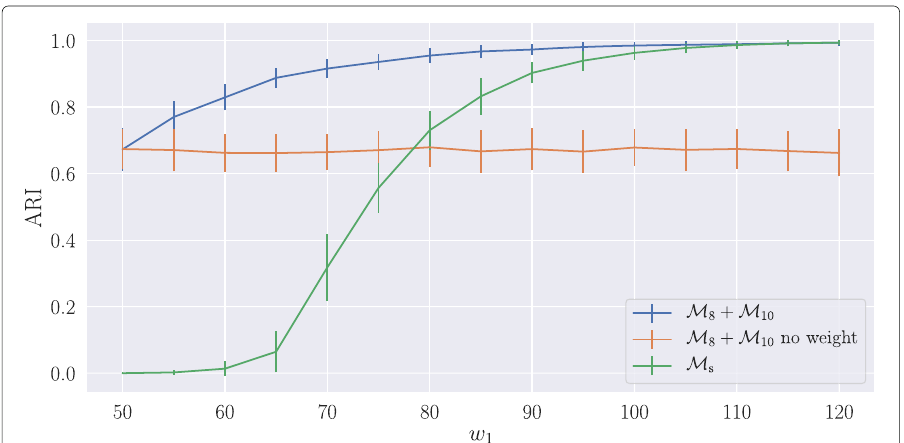
Fig. 16 Exploring the performance of structural MAMs based on M 8 and M 10 on Example 1 (see Fig. 5). Each block contains 100 nodes. We compare both to the unweighted case, and to the symmetrized case. We perform 100 repeats, and error bars are one sample standard deviation